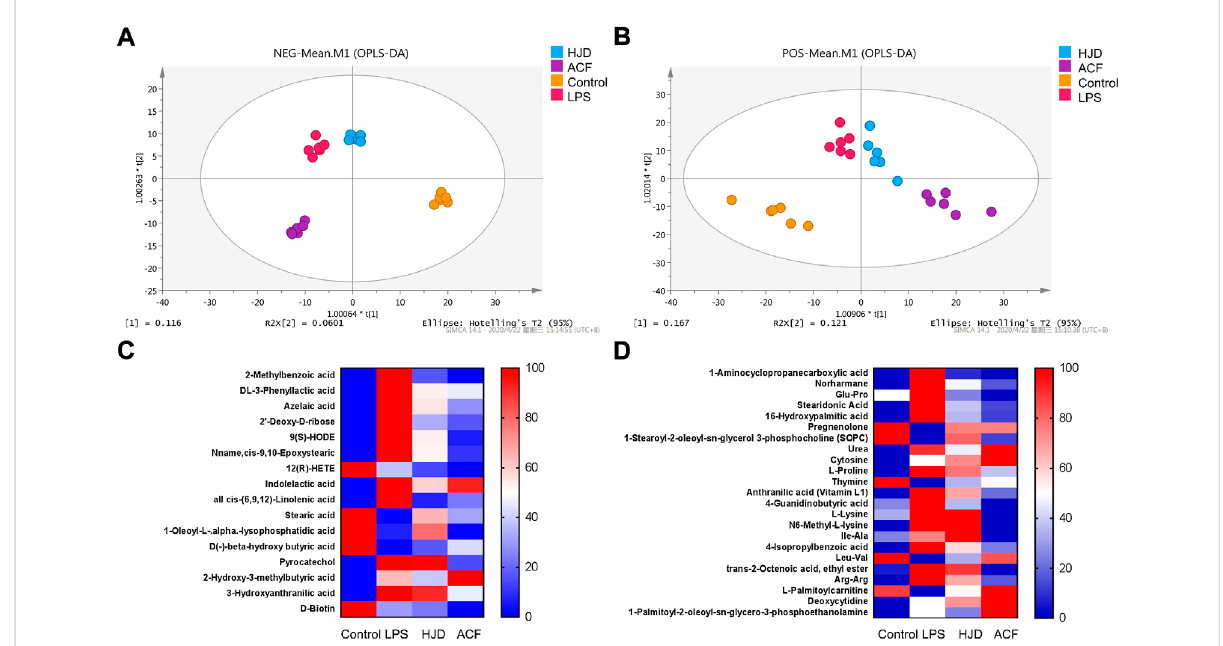
FIGURE 6 Score plots according to OPLS-DA analysis based on MS data from the serum of all groups and heatmap visualization of the differential metabolites. (A) negative ion mode; (B) positive ion mode. (C) negative ion mode; and (D) positive ion mode. Columns represent groups, and rows represent metabolites, and the color indicates metabolite quantities, where red means upregulated and blue means